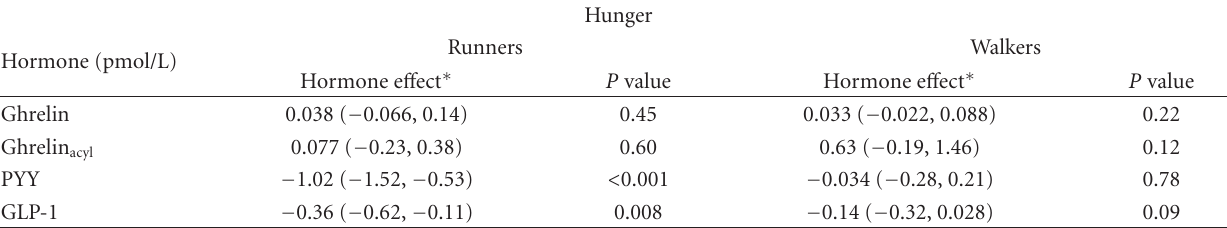
Table 6: Association of hormone concentrations with hunger ratings.